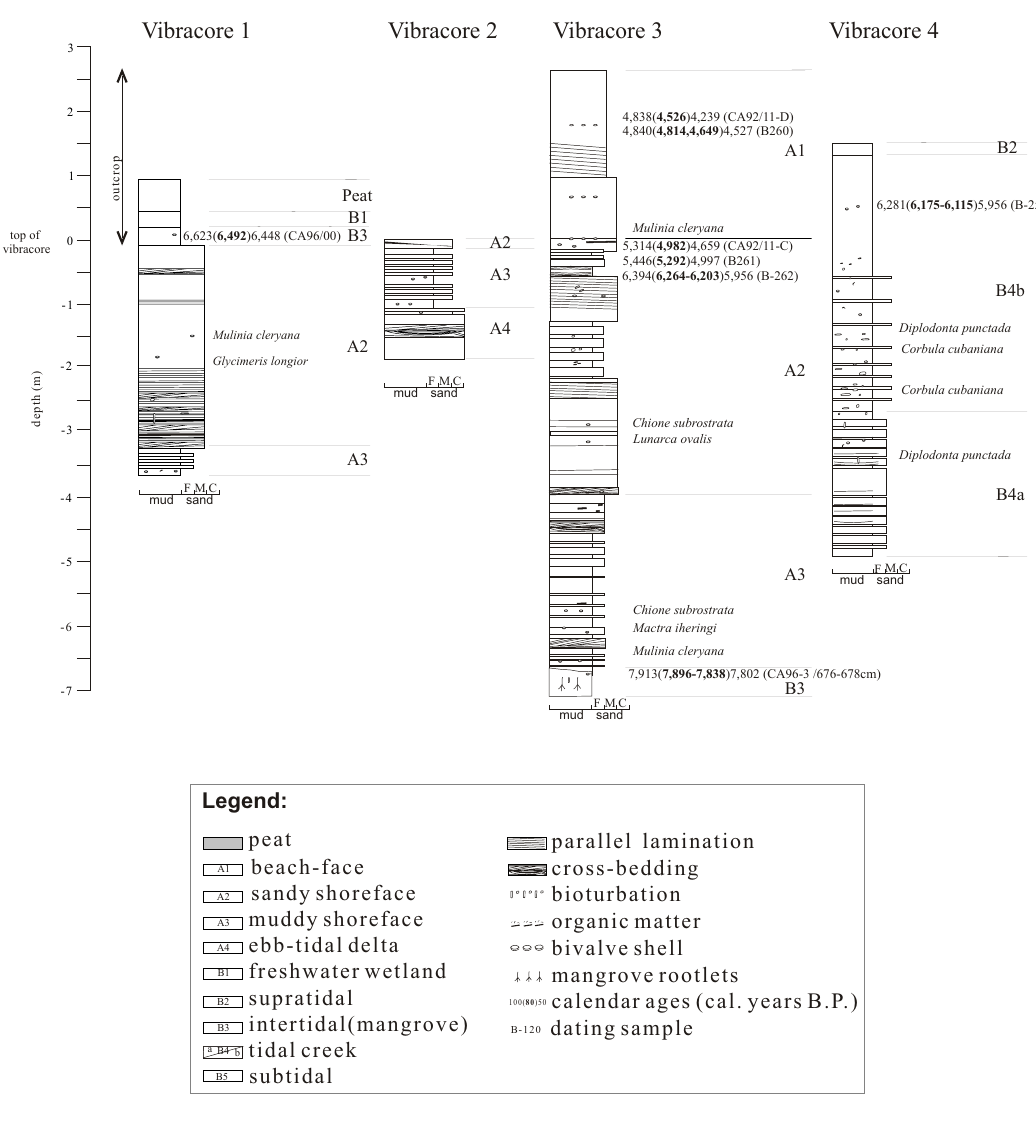
Fig. 6 – Sedimentary facies of vibracores 1, 2, 3 and